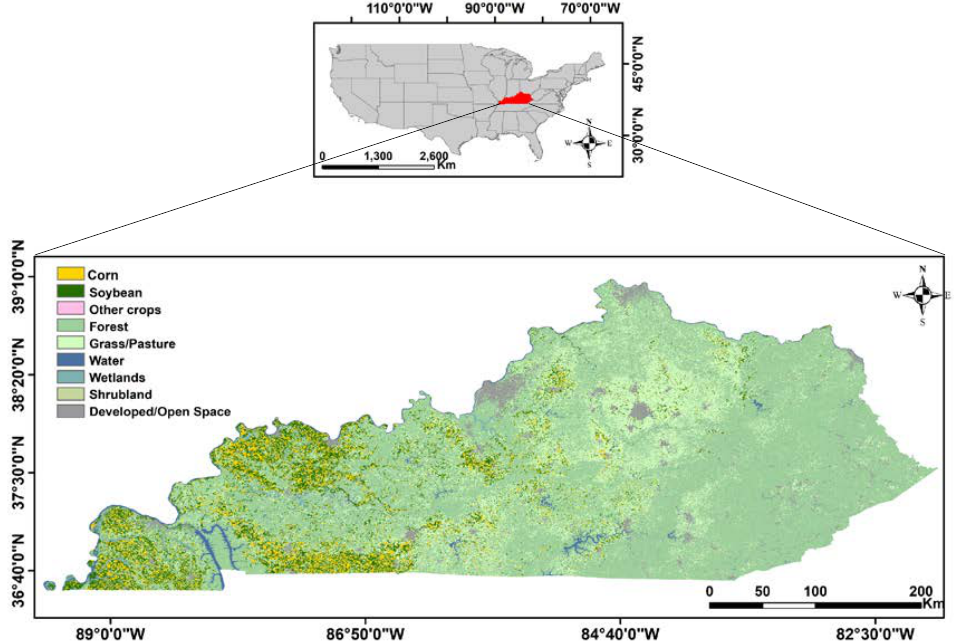
Figure 1. Maps of the study area (Kentucky, overview, and CDL (Cropland Data Layer is derived from USDA NASS)).